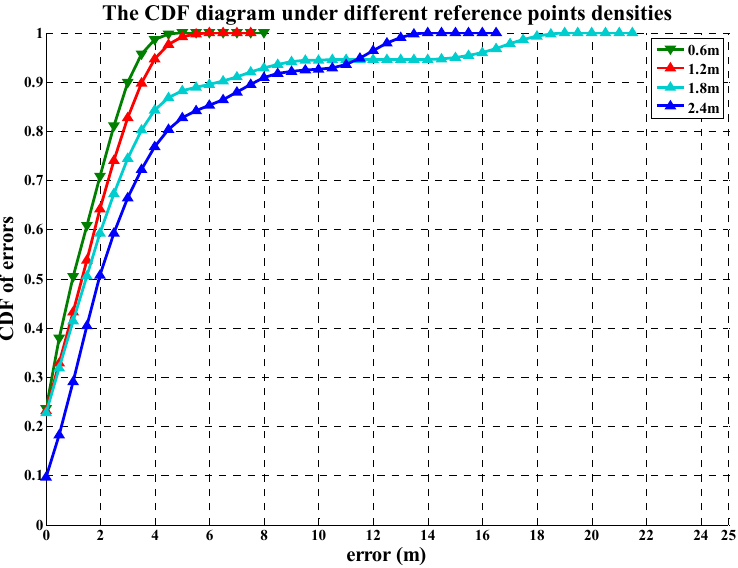
Figure 18. The CDF diagram under different reference point densities.